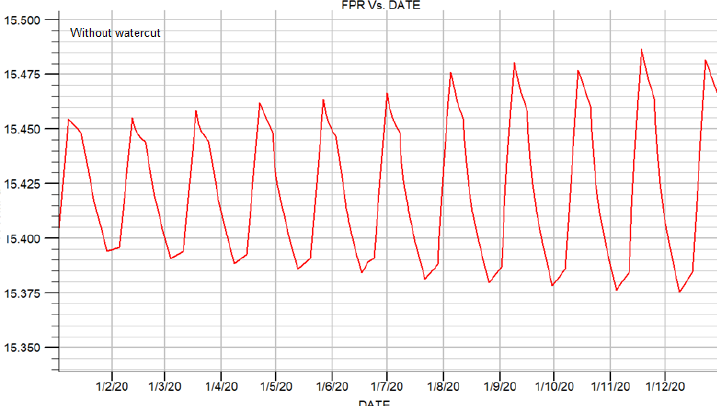
Figure 5. Field pressure (FPR) profile of all three wells (X2, X6, and H1) with schedule 1wkInj- 1wkShut-2wkProd-1wkShut for 1 year.